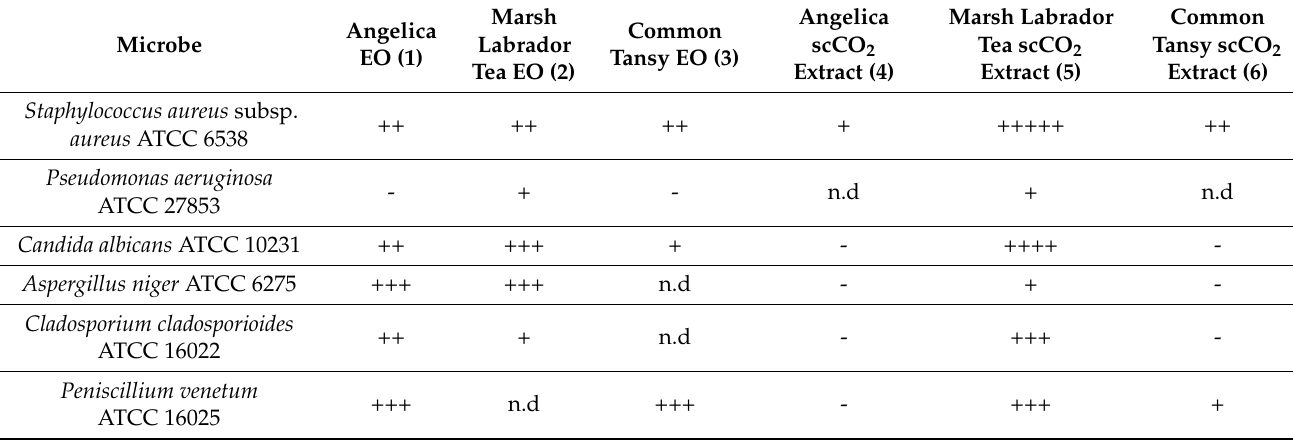
Table 9. Antimicrobial activities of the EOs ( 1 – 3 ) and scCO 2 extracts ( 4 – 6 ) of Angelica, marsh Labrador tea and common tansy evaluated by growth inhibitory